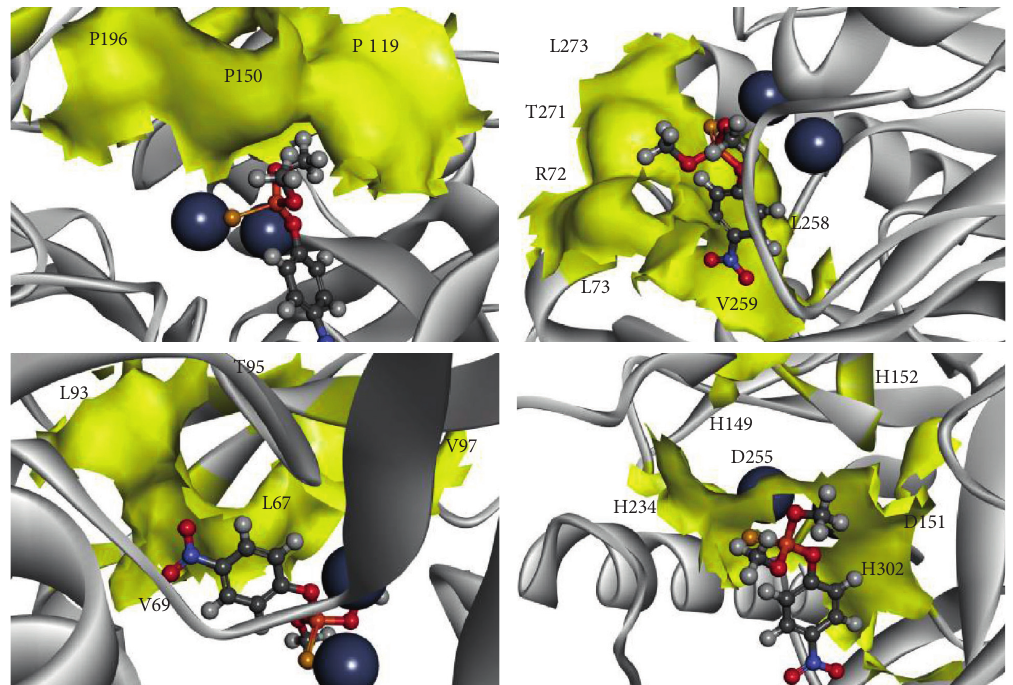
Figure 1: The conformation of Pseudomonas sp. WBC-3 MPH and the methyl-parathion complex. The MPH and methyl-parathion complex were constructed using CDOCKER of Discovery Studio, and the docking pose was further optimized by MD analysis. MPH and Zn 2+ are shown in carton and deep purple ball, respectively. The methyl-parathion is shown in lines, while the residues within 5 ˚A of methyl- parathion are shown as surface in different views.